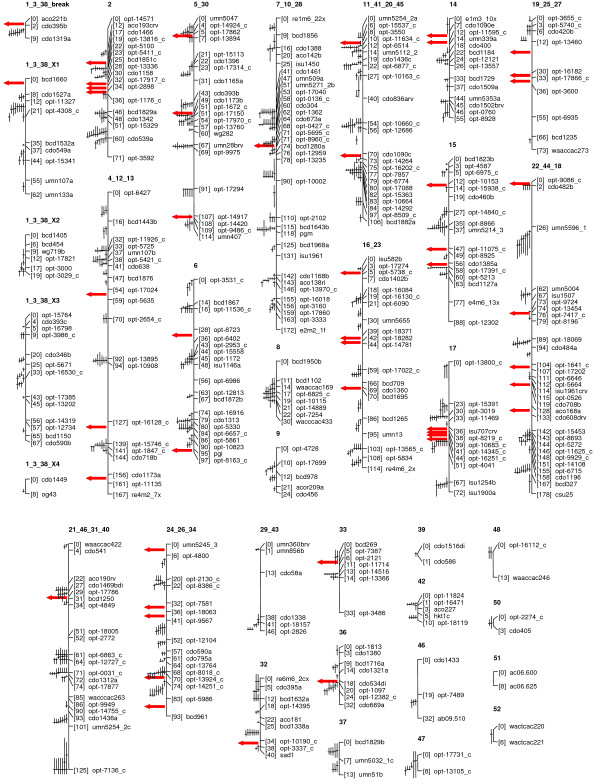
KxO Linkage map. A framework version of the new 'Kanota' × 'Ogle' linkage map showing placement of additional markers (cross-hairs). Vertical bars on cross-hairs indicate the tendency of a placed marker to stretch the interval. The bars are 1/4 of the length that the interval would be if the marker were placed at this position. Where the number of crosshairs exceeded ten they were replaced with a red arrow. A high-resolution multi-page version of this figure is presented in Additional file 7. Additional details and a complete listing of placed marker names are found in Additional file 8.